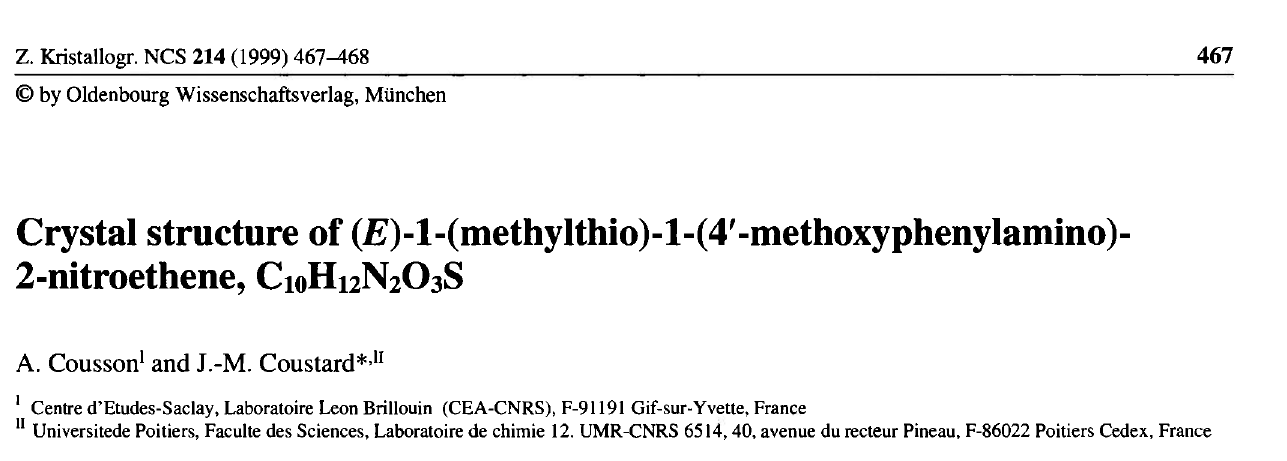
Table 1. Data collection and handling.